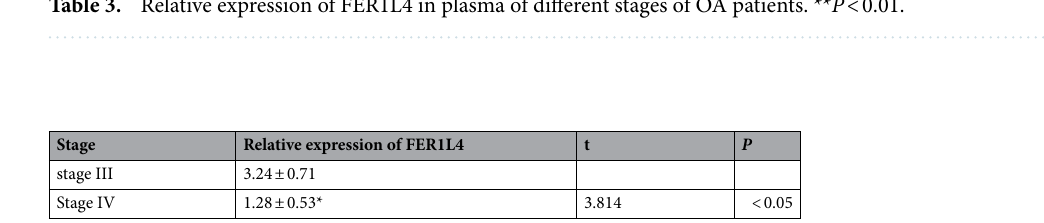
Table 3. Relative expression of FER1L4 in plasma of different stages of OA patients. ** P < 0.01.